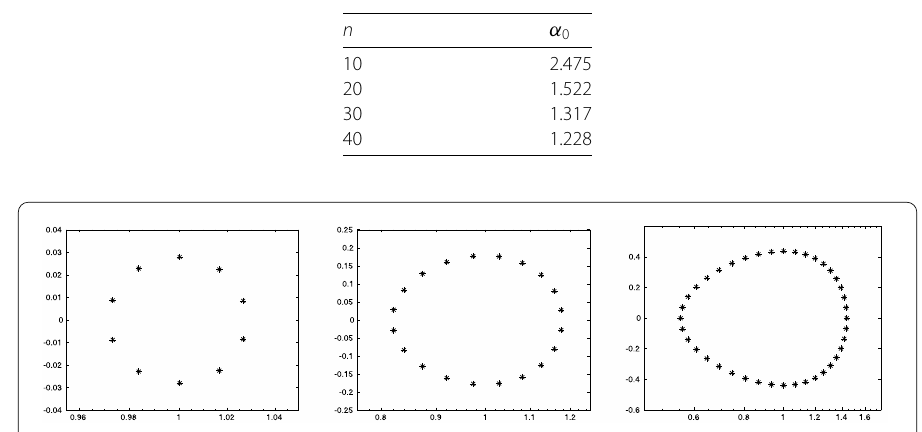
Table 4 The values of α 0 in Conjecture 5.5 in dependence of n